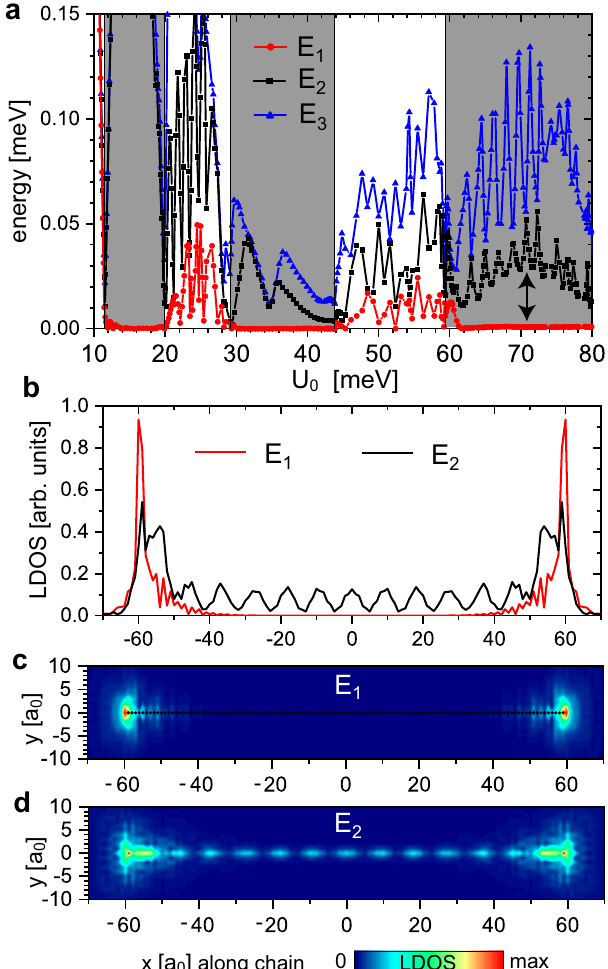
x [a 0 ] along chain 0 maxLDOS Fig. 3 Majorana zero mode at the end of line defects. a Energies of the three lowest energy states, E 1 , E 2 , E 3 as a function of scattering strength U 0 for a line defect of length L = 119 sites in the topological phase with Chern number C = − 1 and ( JS , α , Δ μ ) = (7.5, 7, 0) meV. Here, α is the Rashba spin – orbit coupling, and JS is the magnetic exchange strength. The regions of U 0 where the line defect exhibits a zero-energy state at its ends are shown using a gray background. b Linecut of the local density of states along the line defect for the two lowest energy states at E 1 , E 2 , and U 0 = 71 meV. The plot of the local density of states at energies c E 1 and d E 2 for U = 71 meV. Filled black circles in c indicate the positions of the defects. 0 The color bar represents the normalized local density of